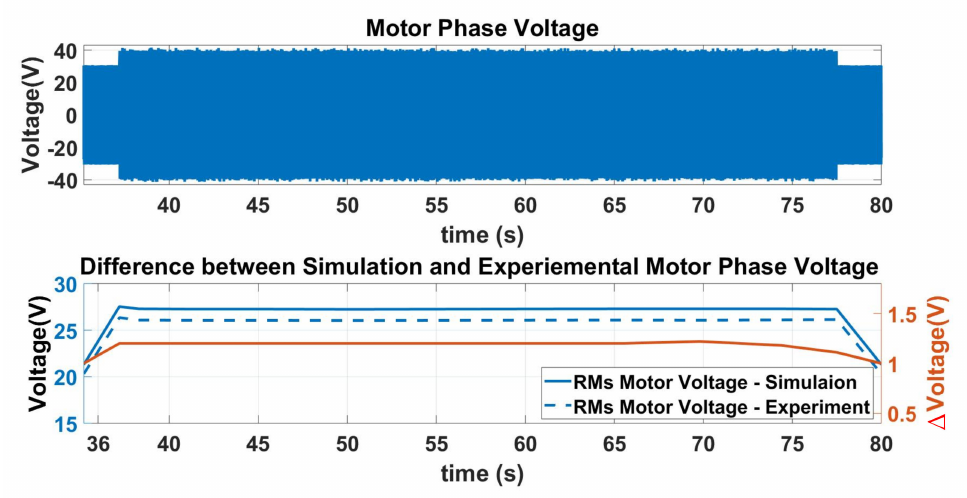
Figure 13. Hardware motor phase voltage and difference between simulation and experimental voltage.